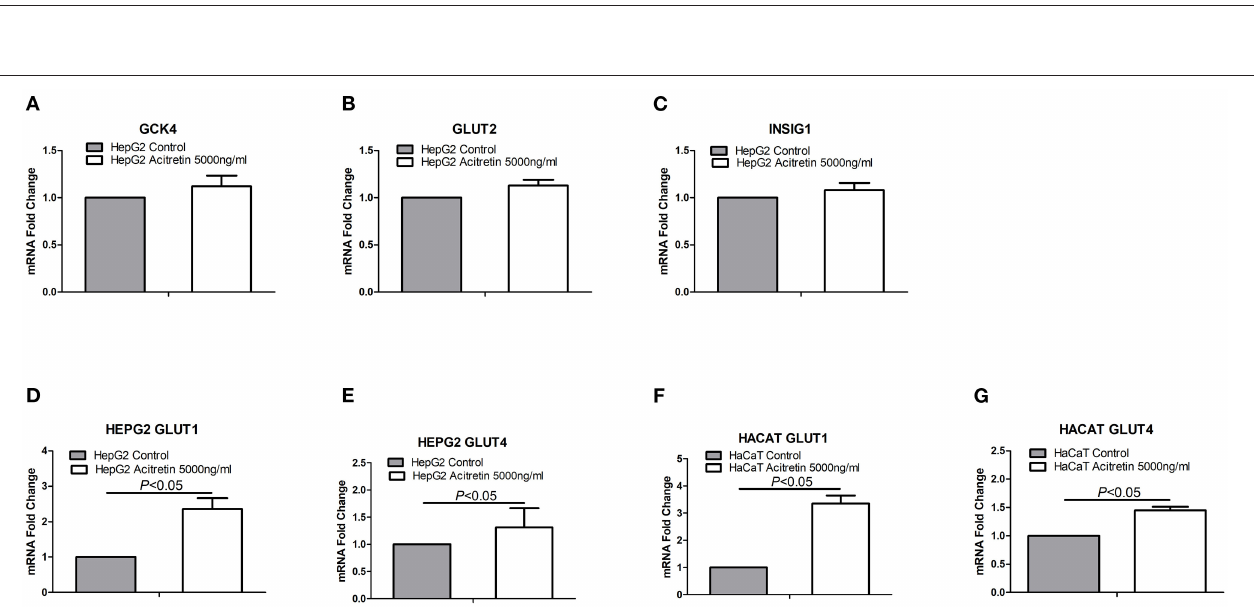
FIGURE 2 | The uptake rate of 2-NBDG in HaCat cells and HepG2 cells when treated with acitretin. Legend: (A,B) The uptake of 2-NBDG by HaCaT and HepG2 cells was observed by fluorescence microscopy with or without acitretin incubation for 36h; (C,D) The uptake of 2-NBDG by HaCaT cells was measured by flow cytometry with or without acitretin incubation for 36h; (D,F) The uptake of 2-NBDG by HepG2 cells was measured by flow cytometry with or without acitretin incubation for 36h.